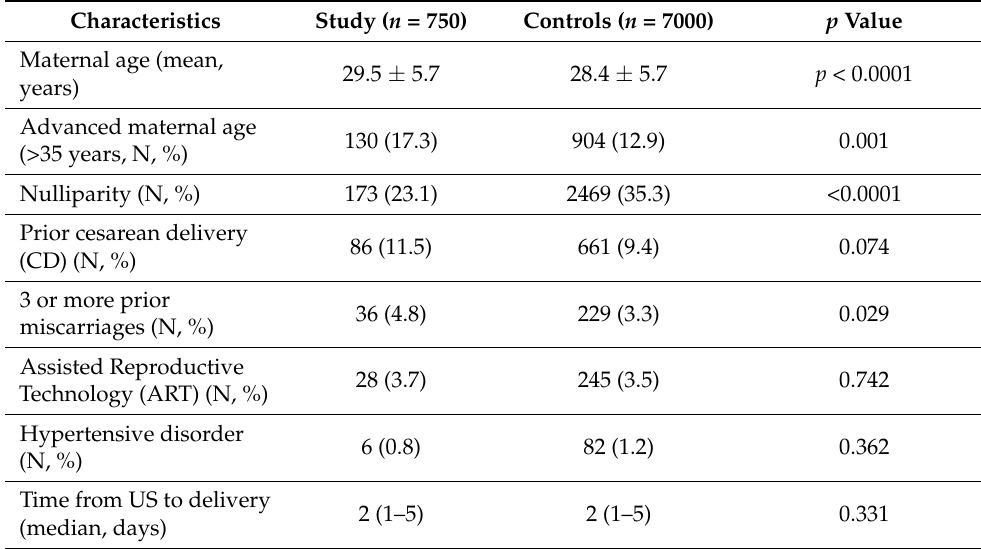
Table 1. Maternal demographic and clinical Characteristics.